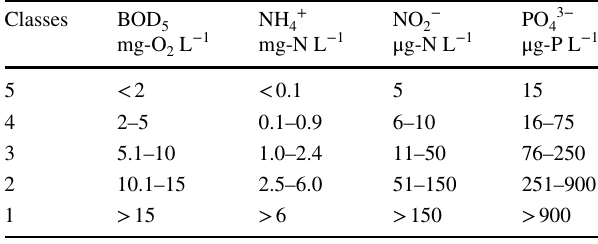
EC electrical conductivity (mS cm −1 ), T (°C), all other values except pH in mg L −1 Table 2 Classes for the organic pollution index (OPI) calculus